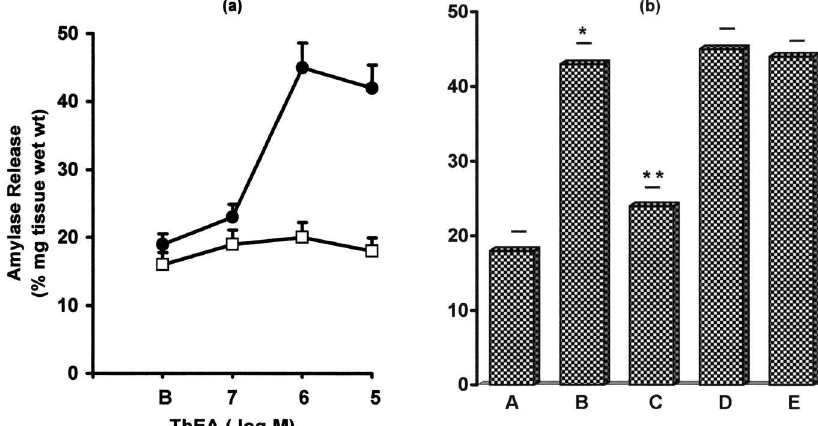
FIG. 4. (a) Effect of the H 1 receptor antagonist (1 ´ 10 –6 M) pyrilamine ( h ) on the dose–response curve of the H 1 receptor agonist ThEA ( d ) upon amylase release by rat submandibular gland slices. Tissues were incubated for 30min in the presence or absence of H 1 receptor antagonist, and the the dose–response curves to ThEA were obtained. Values presented as the mean ± SEM of seven experiments in each group. (b) Effect of the H 1 receptor agonist (1 ´ 10 –7 M) ThEA alone (B), or in the presence of the H 1 receptor antagonist (1 ´ 10 –6 M) pyrilamine (C), the H 2 receptor antagonist (1 ´ 10 –6 M) cimetidine (D), and the NOS inhibitor (5 ´ 10 –5 M) L -NMMA (E) upon basal values (A). Values presented as the mean ± SEM of eight different determinations in each group. Tissues were incubated for 30min in the presence of different inhibitors and then ThEA was added. Values are expressed as percentage changes calculated by comparison with the absolute values prior to the addition of ThEA. *